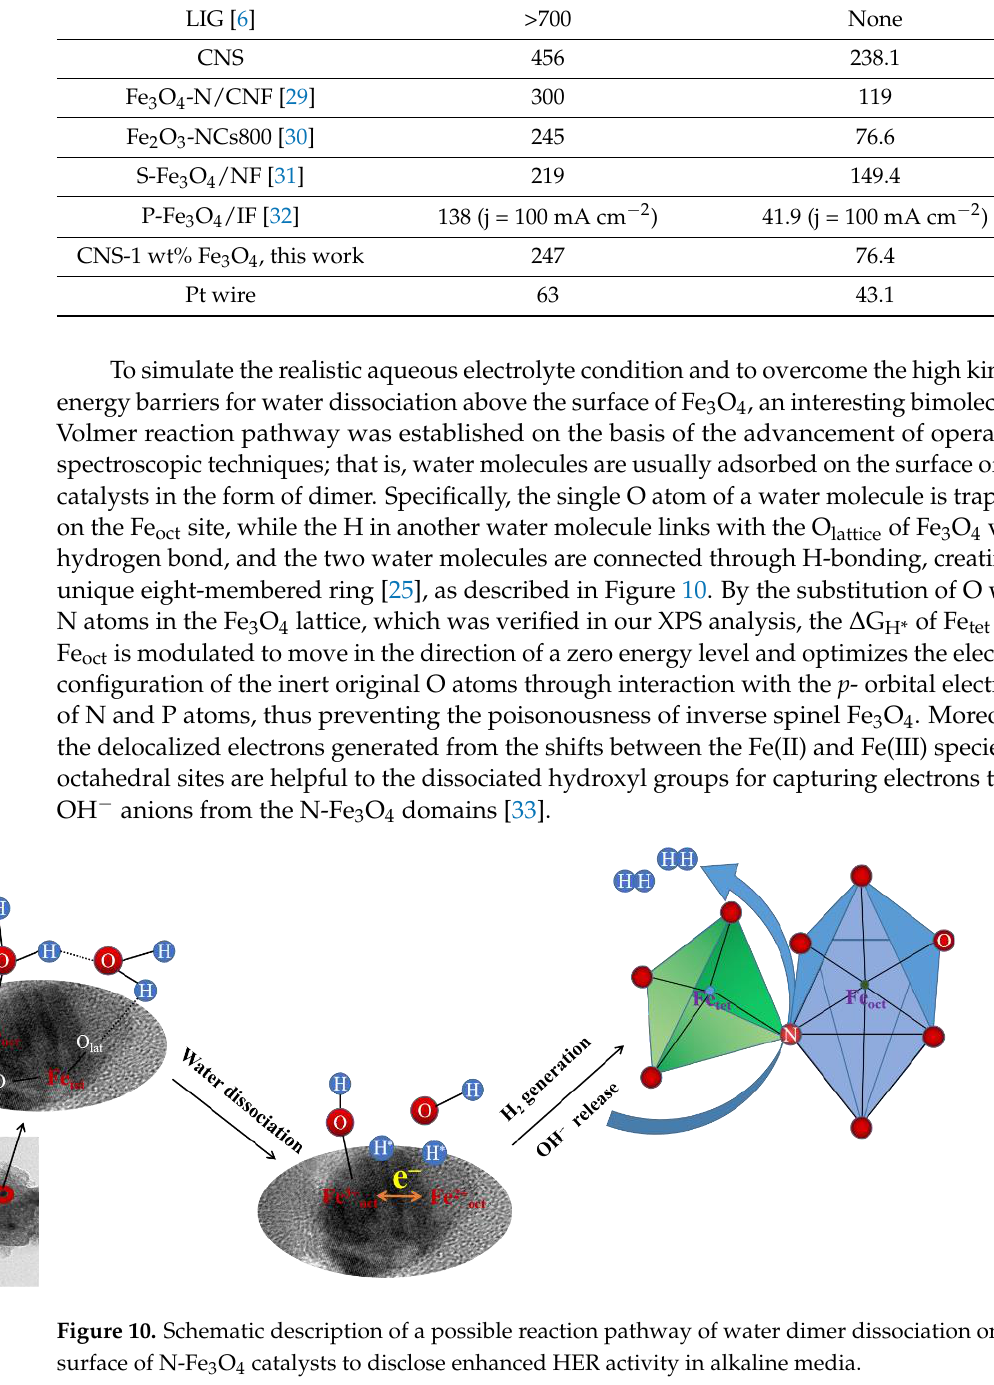
Table 1. Comparison of the HER performance of similar catalysts in 1 M KOH. Electrocatalysts